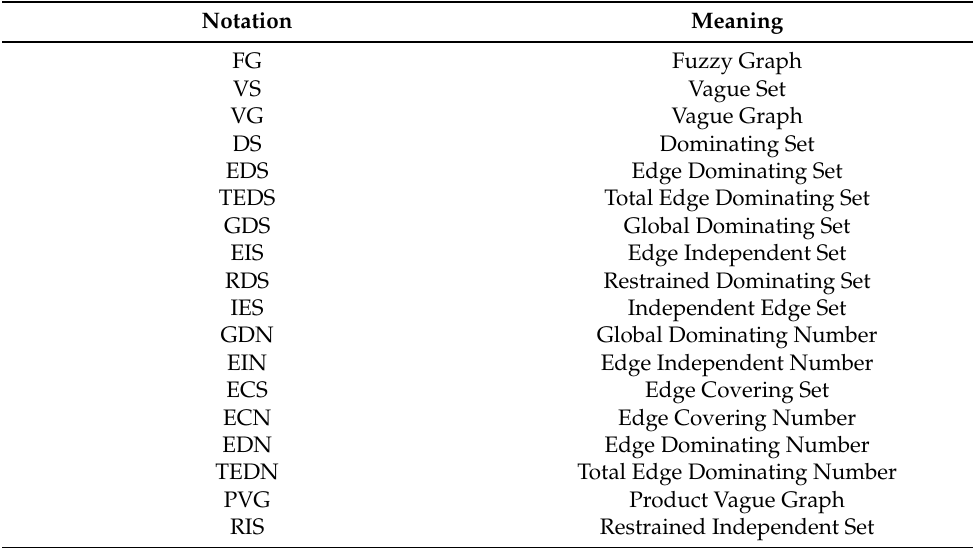
Table 1. Some basic